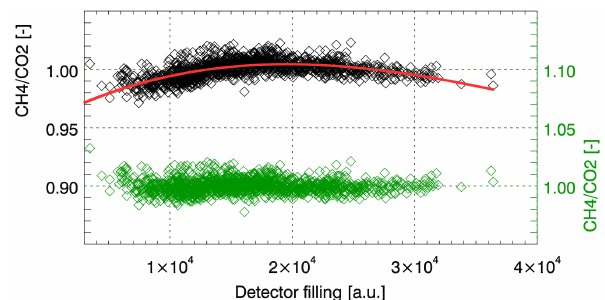
Figure 3. Scatter plot of the ratio of the retrieved CH 4 and CO 2 column over the maximum detector filling on 1 September 2014. Black diamonds: non-corrected data, left scale. Red solid line: fitted third-order polynomial. Green diamonds: corrected data, right scale.